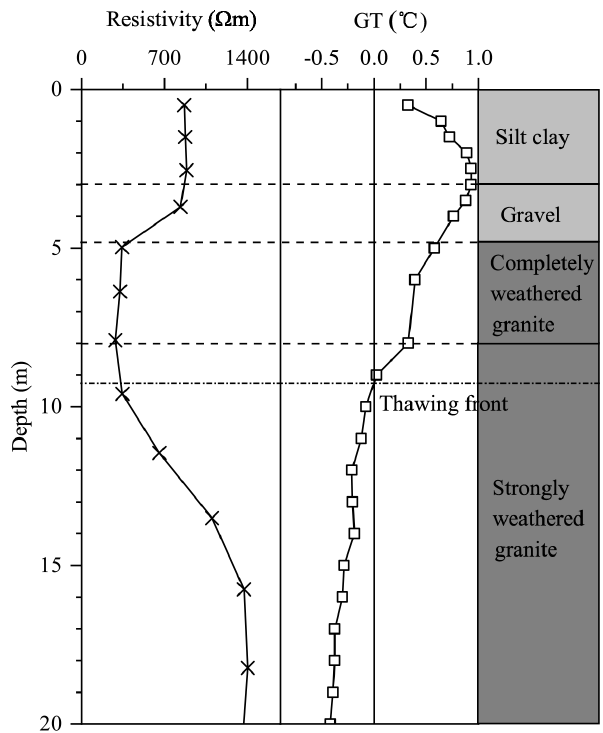
Figure 12. Dependence of electrical resistivity on ground tempera- ture and lithology (in the borehole